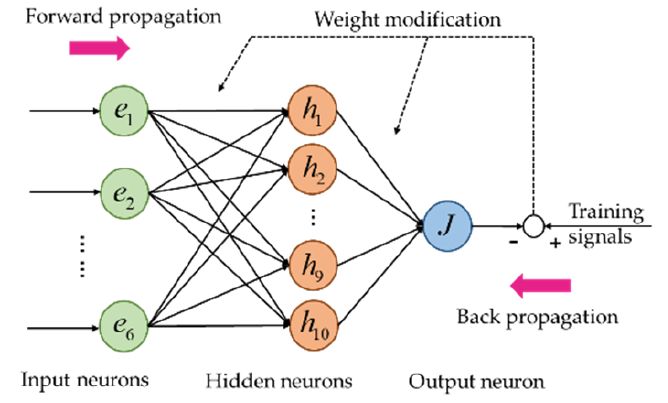
Figure 7. The structure of BP neural network.